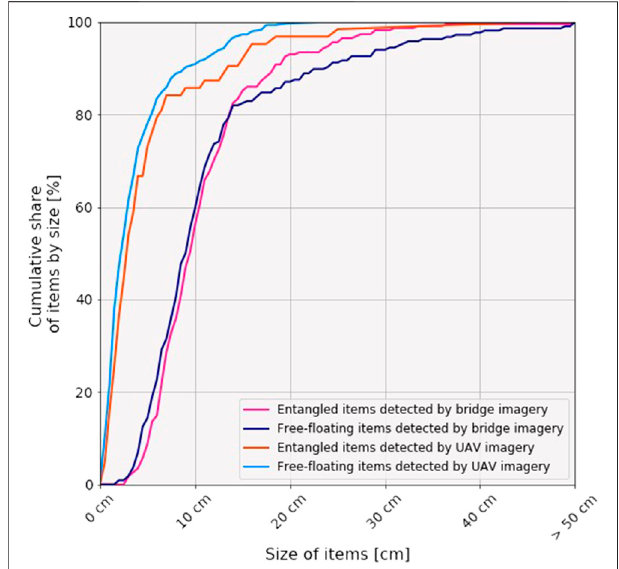
FIGURE 7 | Size distribution of plastic items from the bridge ( n (cid:1) 444) and UAV imagery ( n (cid:1) 359).